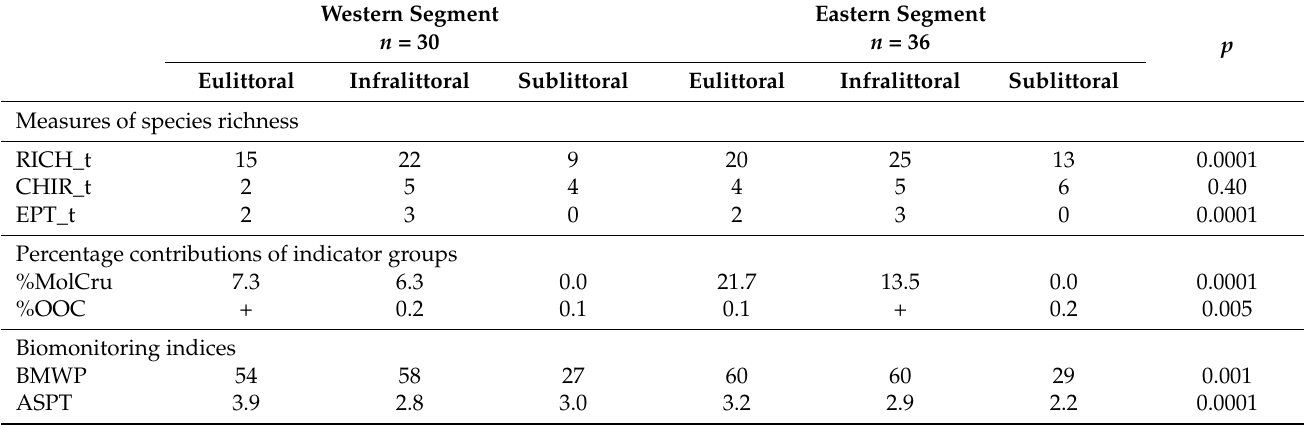
Table 4. Annual mean values of bioassessment matrices of the invertebrate community in different depth zones of two segments of Lake Wicko in 2014–2015; p = significance of differences between zones (one-way ANOVA). Codes: RICH_t— number of all taxa, CHIR_t—number of taxa of chironomid larvae, EPT_t—number of Ephemeroptera + Plecoptera + Trichoptera larvae, %MolCru—percentage contributions of molluscs and large crustaceans to the total abundance of benthic macroinvertebrates, %OOC—percentage contributions of Oligochaeta/Chironomidae abundance ratio to the total abundance of benthic macroinvertebrates, BMWP—Biological Monitoring Working Party score, ASPT—average score per